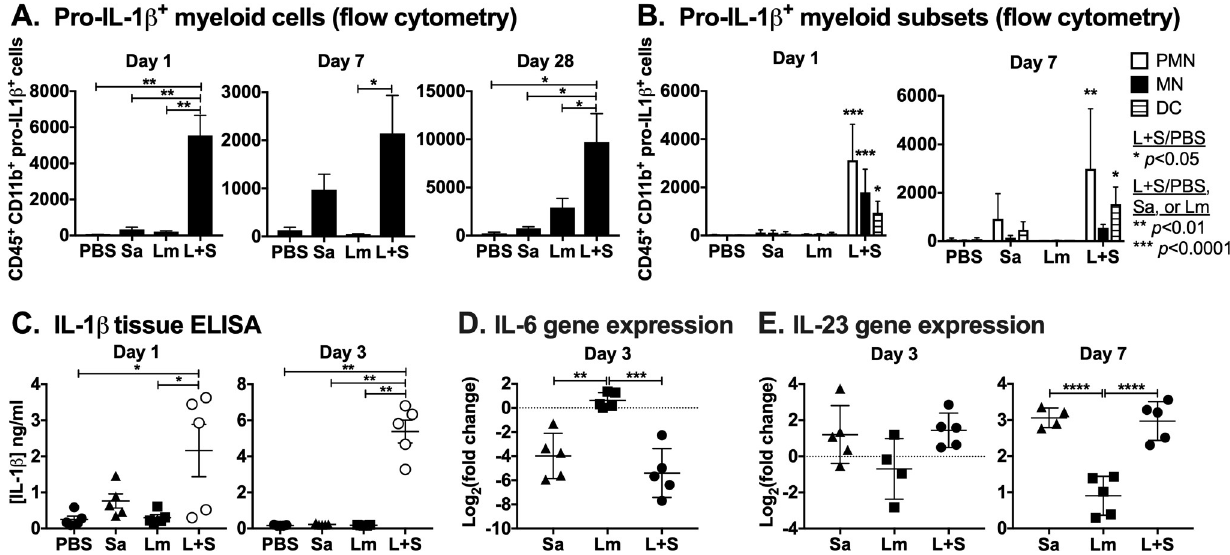
Fig 6. L . major-S . aureus coinfection results in increased pro-IL-1 β expressing myeloid cells, higher IL-1 β levels, and greater IL-23 gene expression in infected tissues. Infected mice ears were homogenized and (A) cultured for 4–5 hours with BFA, PMA, and ionomycin, stained for surface markers and intracellular pro-IL1 β , and analyzed by flow cytometry for (B) numbers of pro-IL-1 β + cells co-staining CD45 + CD11b + Ly6G hi Ly6C int (PMN), CD45 + CD11b + Ly6G - Ly6C hi cells (MN), or CD45 + CD11b + CD11c + (DC) from the ears at days 1 and 7 p.i. (C) Supernatants from homogenized ear tissues were analyzed by ELISA for IL-1 β concentration. (D) IL-6 gene expression from ears 3 days p.i. (E) IL-23 gene expression from ears 3 and 7 days p.i. Data from days 1 and 3 (A-C) and panels D & E represent one experiment and are shown as the mean ± SD of 5 mice/group. Data from day 7 (A & B) from two replicate experiments are shown as the mean ± SEM of 3–6 mice/group. � p < 0.05, �� p < 0.0001 by one-way ANOVA with Tukey’s post-test. PBS = phosphate buffered saline, Sa = S . aureus , Lm = L . major , L+S = L . major + S . aureus .